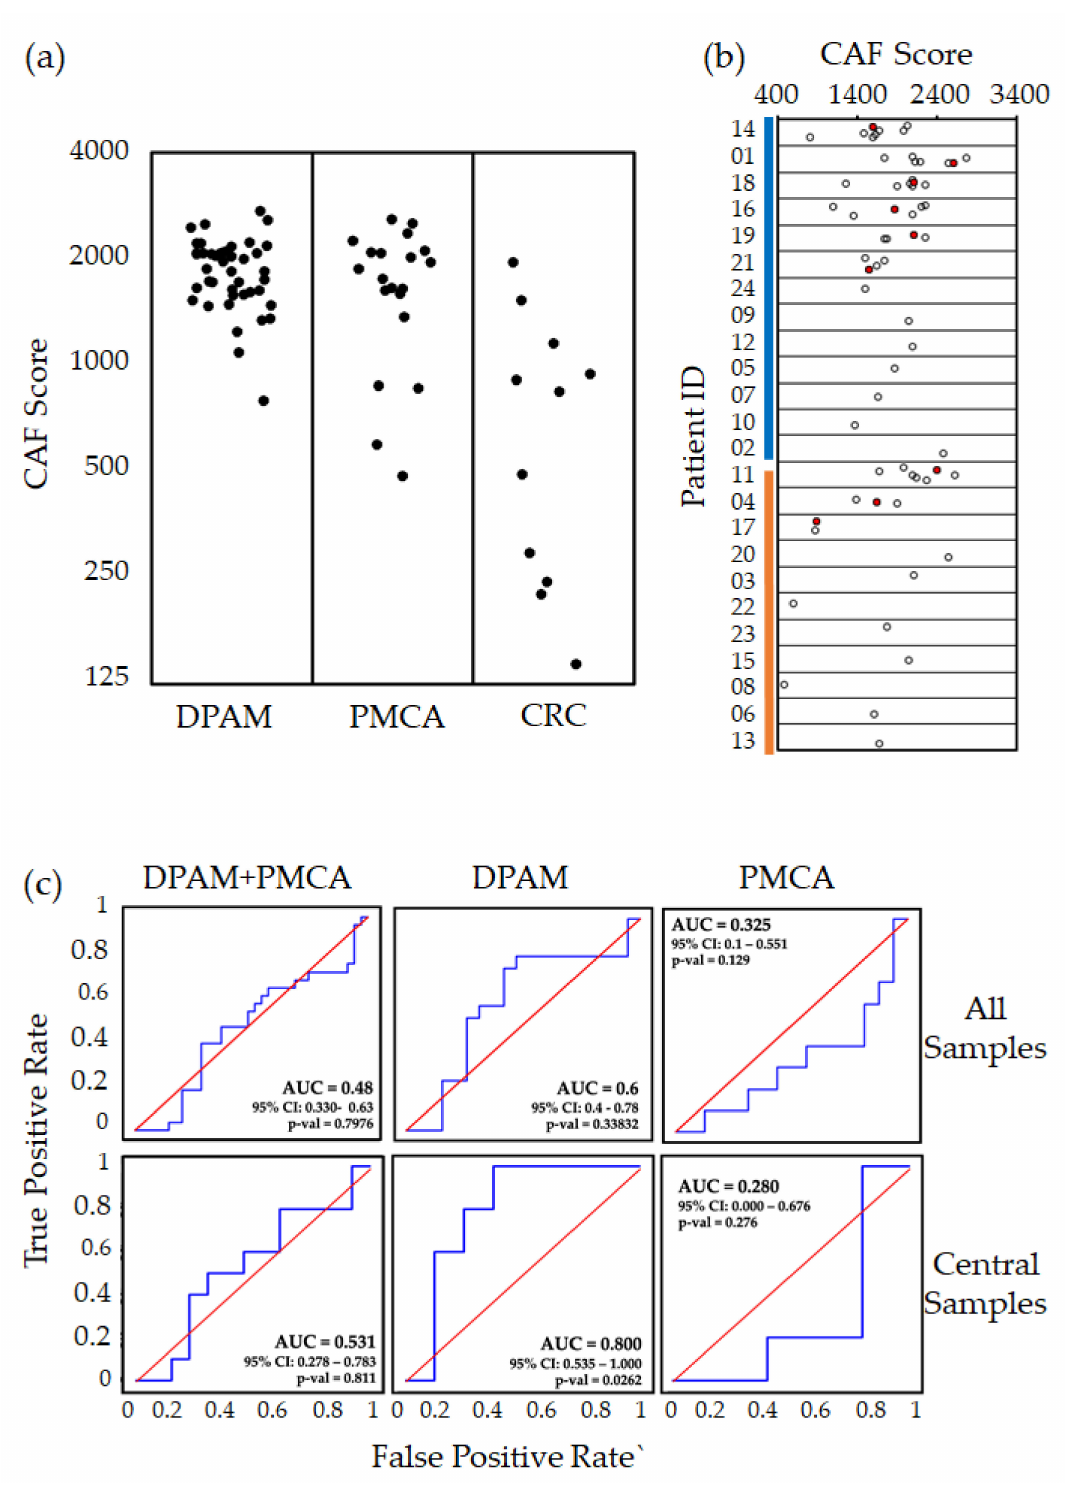
Figure 2. Prognostic performance of the transcriptional CAF score ( a ) Dot plot of cancer-associated fibroblast (CAF) score in DPAM, PMCA, and colorectal cancer (CRC) samples. ( b ) CAF score calculated in each sample subdivided by patient of origin. Red dots represent the central sample for patients with multiple profiles. ( c ) ROC curves for the CAF score vs DFS in the full dataset (DPAM + PMCA), DPAM, and PMCA (DFS event = relapse within 24 months). For patients with multiple profiles, curves in the top row include all samples as if they were from di ff erent patients, while curves in the bottom row only include central samples. AUC = area under the curve; CI = confidence